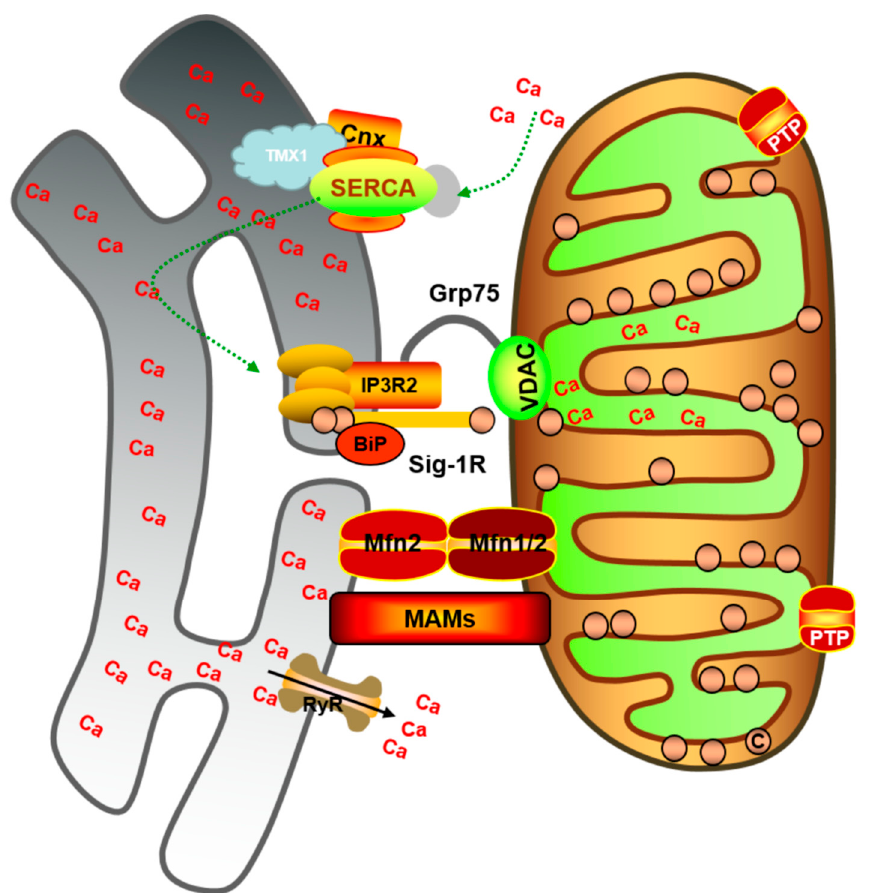
Figure 3. Mitochondria-associated membrane (MAM) protein complex regulating Ca 2+ in cardiomyocytes. There are many MAM complexes between the endoplasmic reticulum (ER) and mitochondria. The IP3R2-Grp75-VDAC complex is an important MAM complex. The Grp75 acts as a bridge between IP3R2 on ER and voltage-dependent anion channel 1 (VDAC1) on the mitochondrial outer